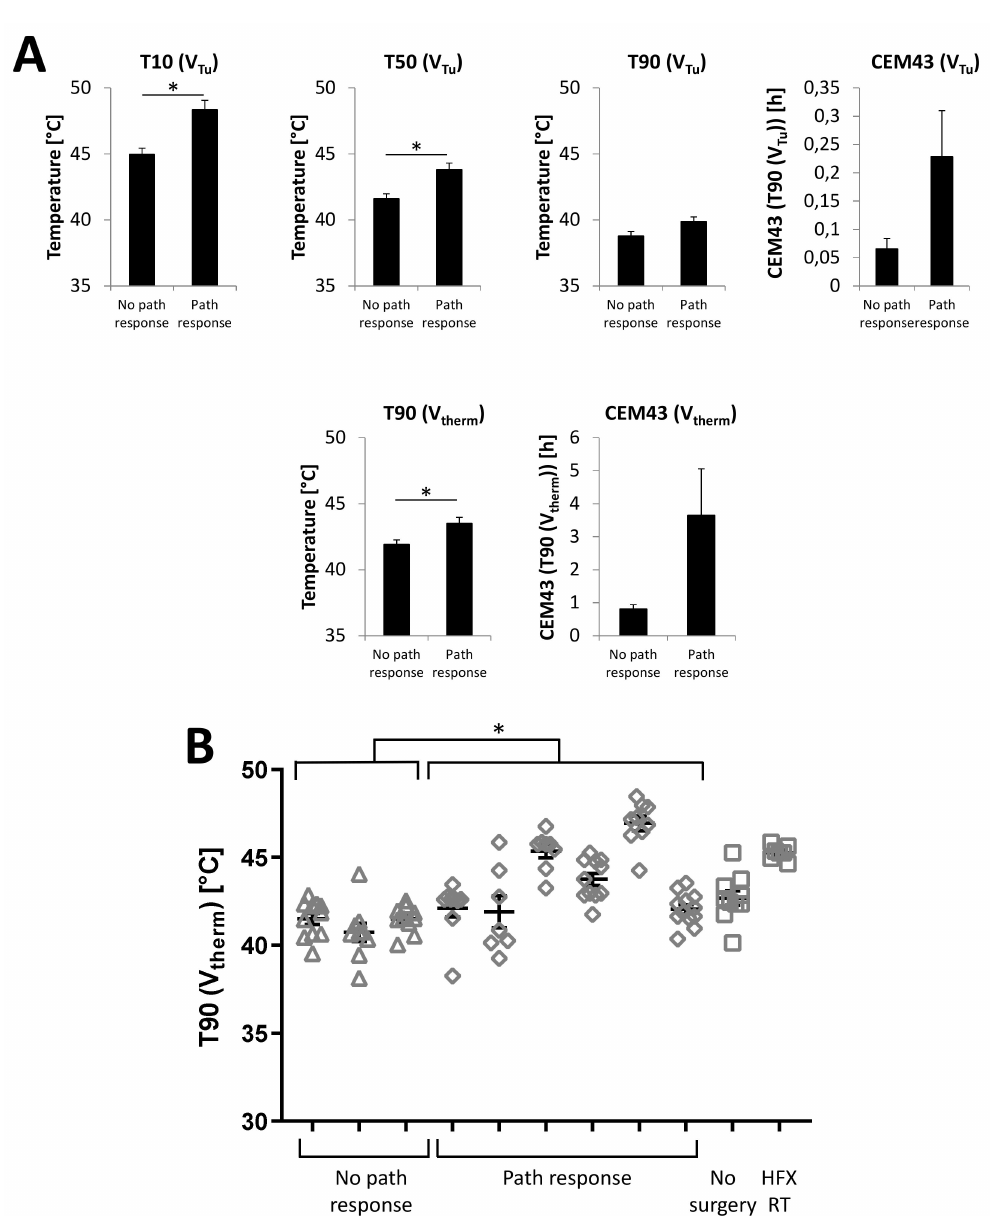
Figure 5. Mean T10 (V Tu ) and T50 (V Tu ) as well as mean T90 (V therm ) were significantly higher in patients who achieved a pathologic response with < 10% vital tumor cells in the resection specimen (three hyperthermia sessions per patient) ( A ). T90 (V therm ) for every hyperthermia treatment grouped for individual patients shows lower temperatures for patients with > 10% vital tumor cells in the resection specimens (triangles) compared to patients achieving a pathologic response (rhombuses). Excluded are the patient not undergoing surgery and the patient who had received hyperfractionated radiotherapy (squares) ( B ). * p <